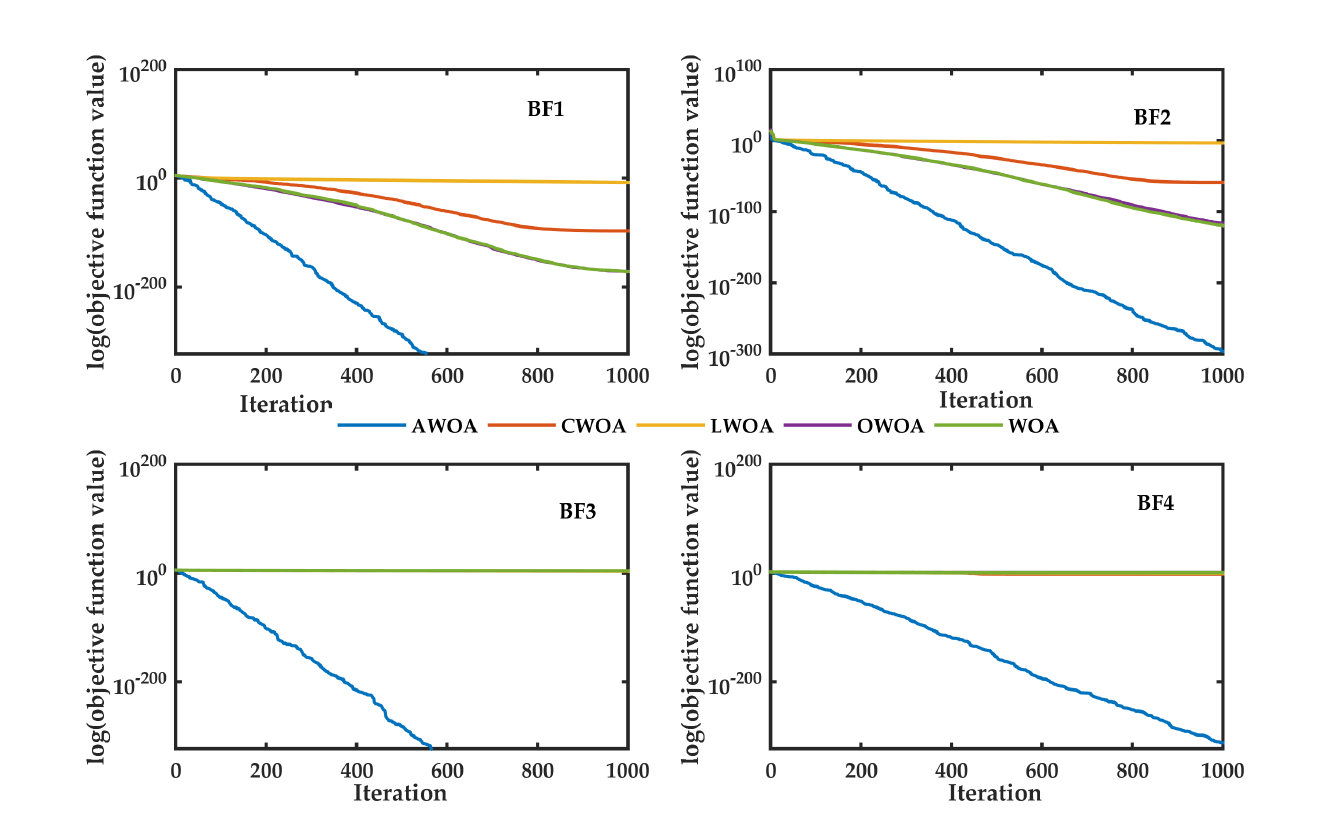
Figure 5. Convergence property analysis of unimodal functions.